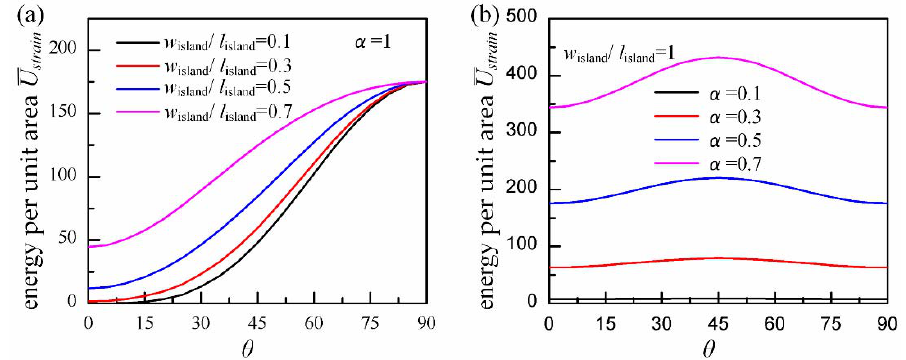
Figure A2. The conformal strain energy per unit area in island with initial angle θ at different width-length ratios ( a ) and different curvature ratios ( b ).